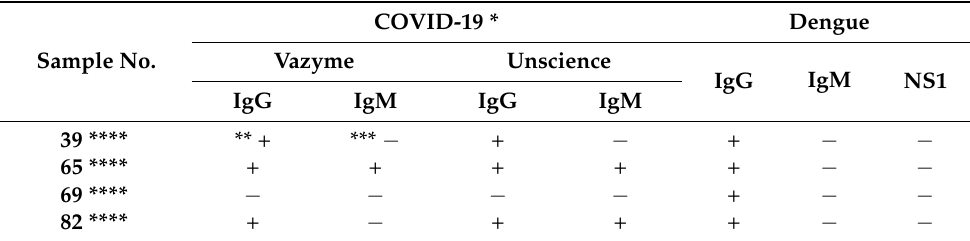
Table 1. Samples from COVID-19 patients with positive dengue antibodies. Sample No.